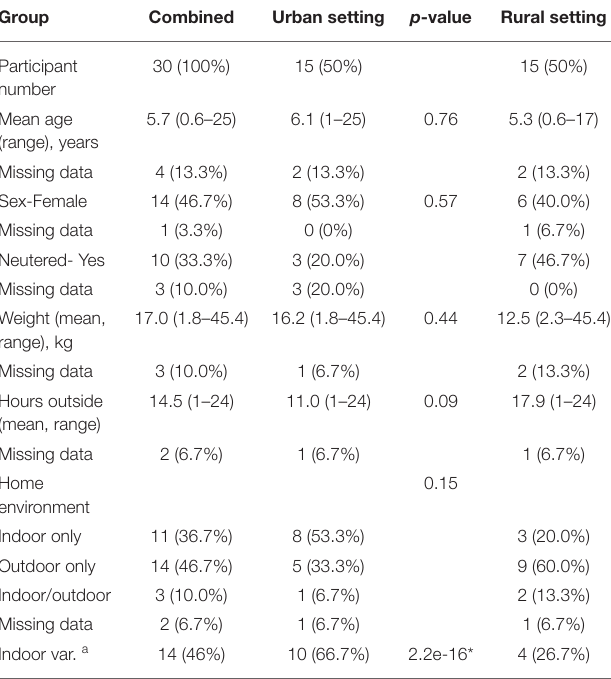
TABLE 1 | Canine demographics and characteristics. TABLE 2 | Distance between owner home and the nearest neighborhood monitor